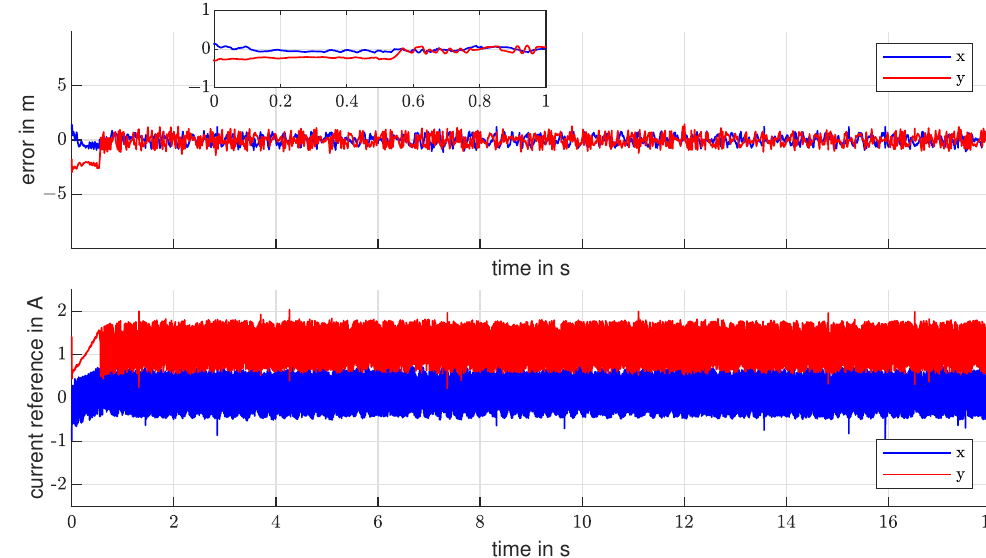
Figure 13. Displacement error and current reference i ∗ with current controller dynamics for both bearings operating at constant reference